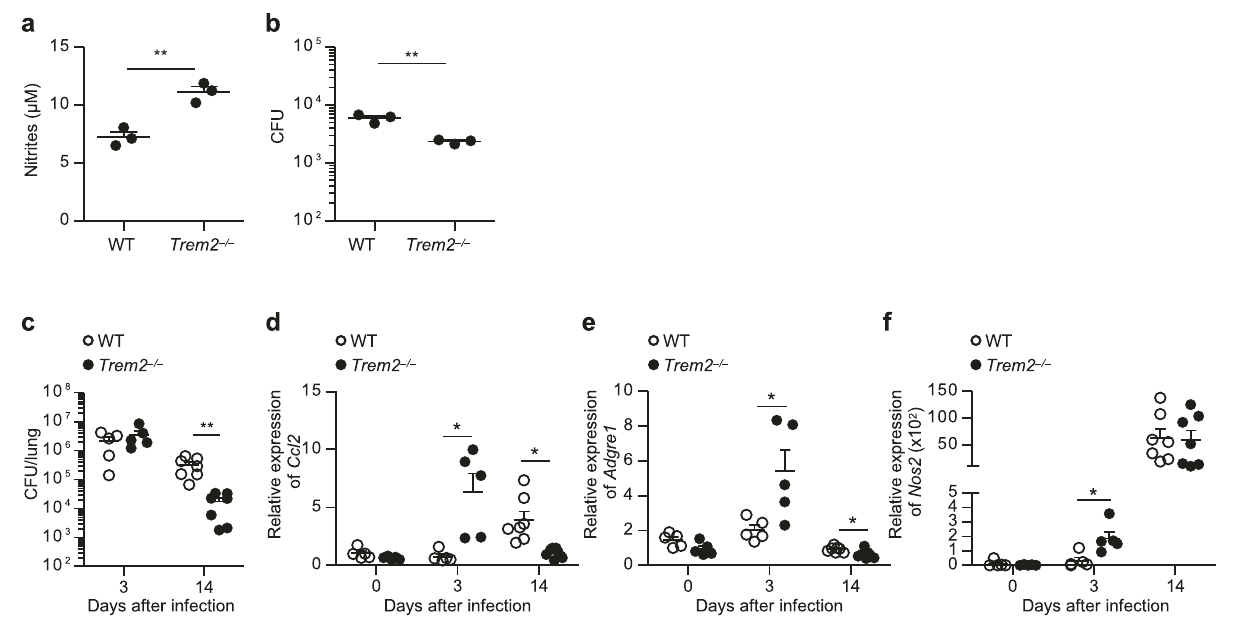
Fig. 7 TREM2 de fi ciency accelerates the clearance of mycobacterial infection. a , b WT or Trem2 − / − BMDMs were infected in vitro with M. bovis BCG (MOI 10) for 4 h. After washing, the cells were further cultured for 24 h, and nitrite concentration in the culture supernatant was measured by Griess assay ( a ). The cells were collected, lysed, and CFUs of M. bovis BCG were counted ( b ). The statistical signi fi cance was calculated by two-tailed unpaired t test. c – f WT or Trem2 − / − mice (day 3, n = 5; day 14, n = 7) were infected intratracheally with 7.5 × 10 6 CFU of M. bovis BCG. The lung tissues were collected at days 3 and 14 after infection, homogenized, and CFU were determined ( c ). The expressions of Ccl2 , Adgre1 , and Nos2 in the lungs from uninfected control ( n = 5) and infected mice were analyzed by qRT-PCR ( d – f ). Data are presented as the mean ± SEM and are representative of two independent experiments. The statistical signi fi cance was calculated by two-tailed unpaired t test. * p < 0.05, ** p < 0.01. Source data are provided as a Source data fi